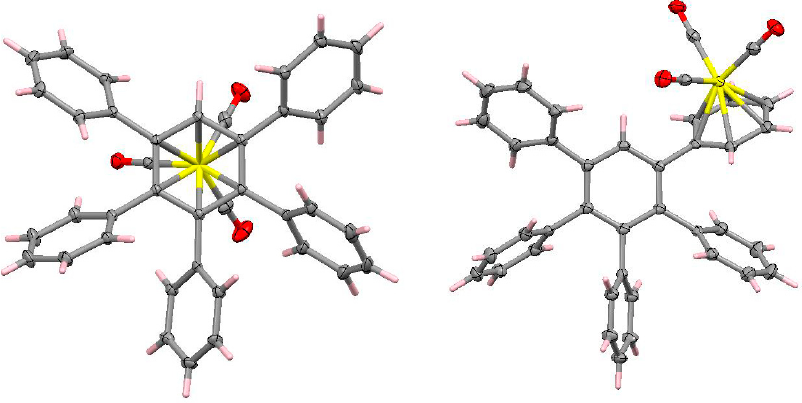
Figure 15. Molecular structures of (C 6 Ph 5 H)Cr(CO) 3 ; ( left ) tripod bonded centrally, 33 ; ( right ) tripod bonded to a peripheral ring in 34 .